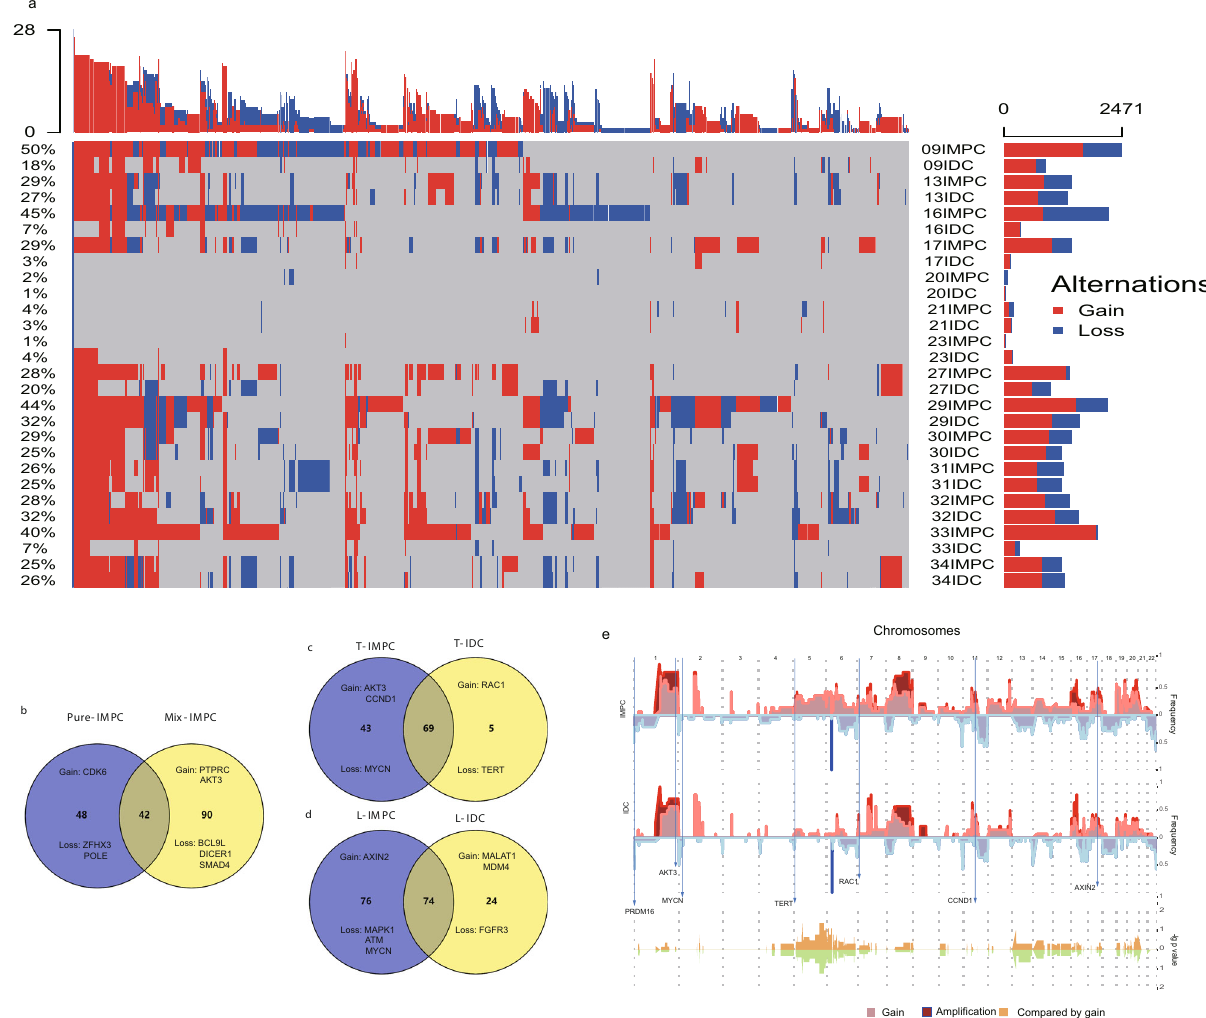
Fig. 3 Comparison of genomic CNVs in IMPC samples at the level of multiple-cell clusters between pure and mixed IMPC-IDC. a Genomic CNV landscape in the paired IMPC and IDC components of 14 mixed IMPC-IDC samples. Each row represents a sample; each column represents a genetic locus. The percentages on the left show the genomic instability of each sample across all chromosomal regions, and the bars on the right and top represent the number of different mutations in each sample and the frequency of each genetic locus in the sample, respectively. b – d Venn diagrams re fl ecting common and unique genes with copy-number aberrations in pure IMPC and mixed IMPC-IDC samples ( b ), in IMPC and IDC components of primary tumors ( c ), and in IMPC and IDC components of lymph node metastatic loci ( d ). Common and unique genes with CNVs are labeled in each category. T primary tumor, L lymph node. e CNV spectrum of the IMPC and IDC components in mixed IMPC-IDC samples. The frequency of each site was determined by calculating the number of losses or gains in the IMPC and IDC components. The − log10 unadjusted P values are shown for comparison, and signi fi cantly different CNV genes are labeled with long arrows. The statistic test is a two-sample unequal variance [heteroscedastic] t test,